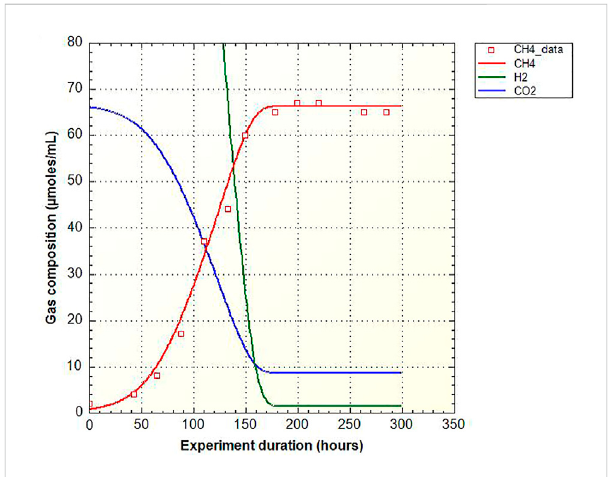
FIGURE 2 Simulation using the microbial kinetic model (Model D) on the experiment by Smigan et al. (1990) of methane production (squares) from hydrogen and carbon dioxide in presence of Lobodice rock and formation water containing bacteria (37 ° C, 1.5